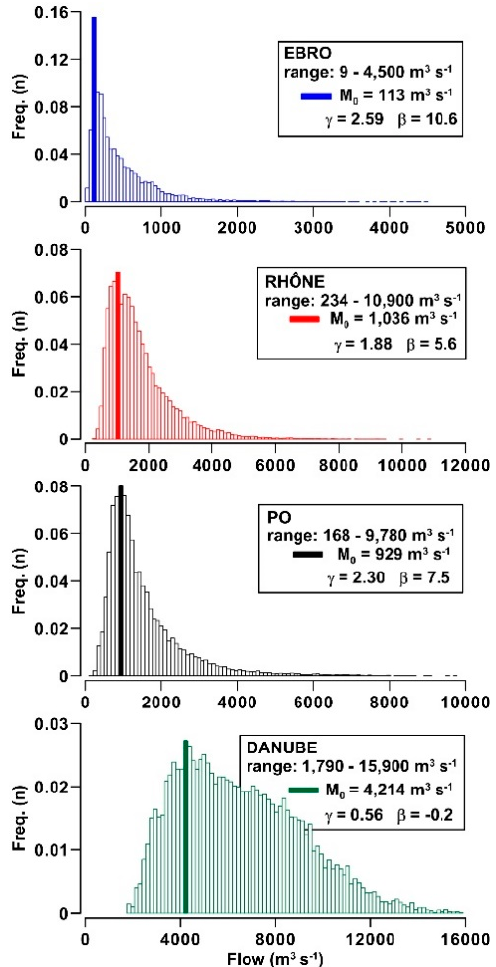
Figure A1. Frequency distributions of daily flows (m 3 s − 1 ) of the rivers and symmetry properties of population data (M 0 = mode, γ = moment coefficient of skewness, β = Kurtosis).